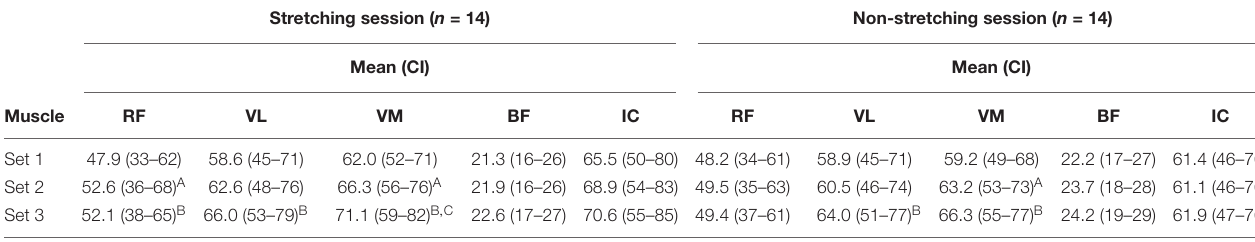
TABLE 3 | Electromyographic analysis adjusted for the percent of maximum voluntary isometric contraction